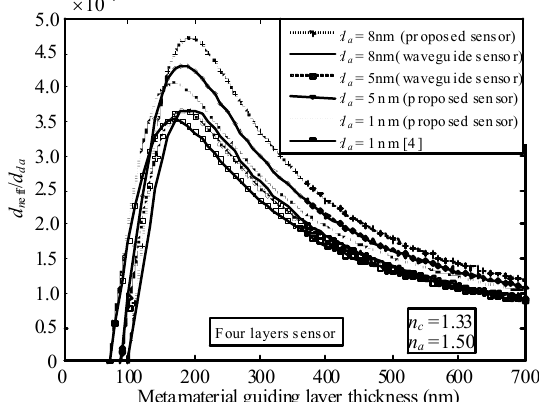
Fig. 6 Plot of adlayer sensitivity variation against film thickness of proposed and conventional four-layer sensors for adlayer refractive index n a = 1.50, in which the refractive indices used are: n s = 1.471 and n c =